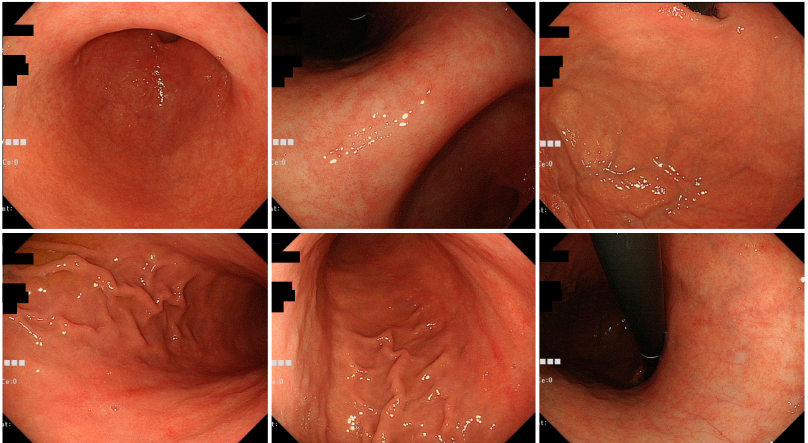
Figure 3. Typical endoscopic images of H. pylori -infected gastric mucosa in the Okinawa group. This patient is an 83-year-old woman. O-2 atrophy is observed, and there are only a few findings of H. pylori infection. Mild spotty redness on the posterior wall of the gastric body is